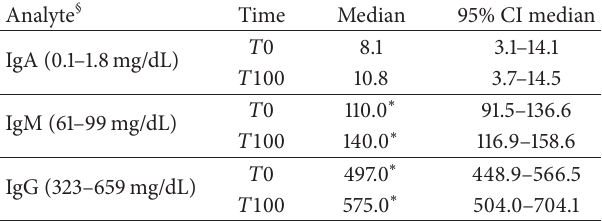
Table 3: Immunoglobulin concentration in Group 3 (7 dogs). Analyte §